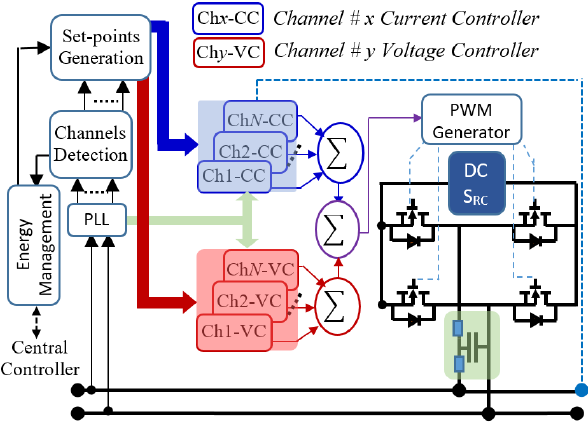
Figure 3. The block diagram of the control system of a source in a multi-channel-based power system.